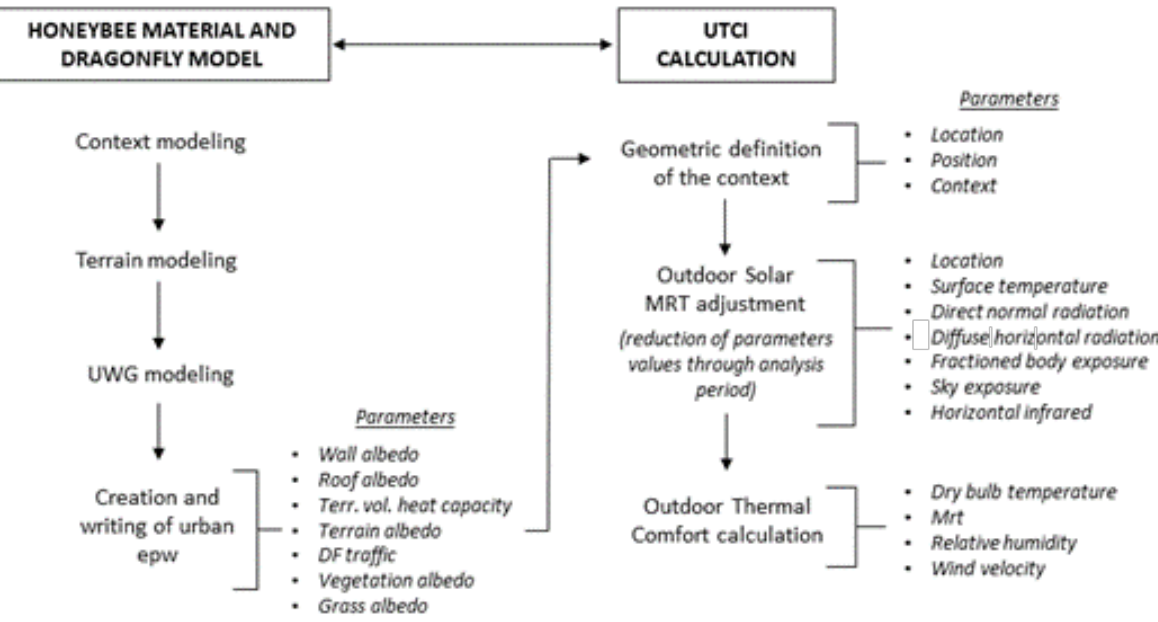
Figure 2. Methodology diagram.